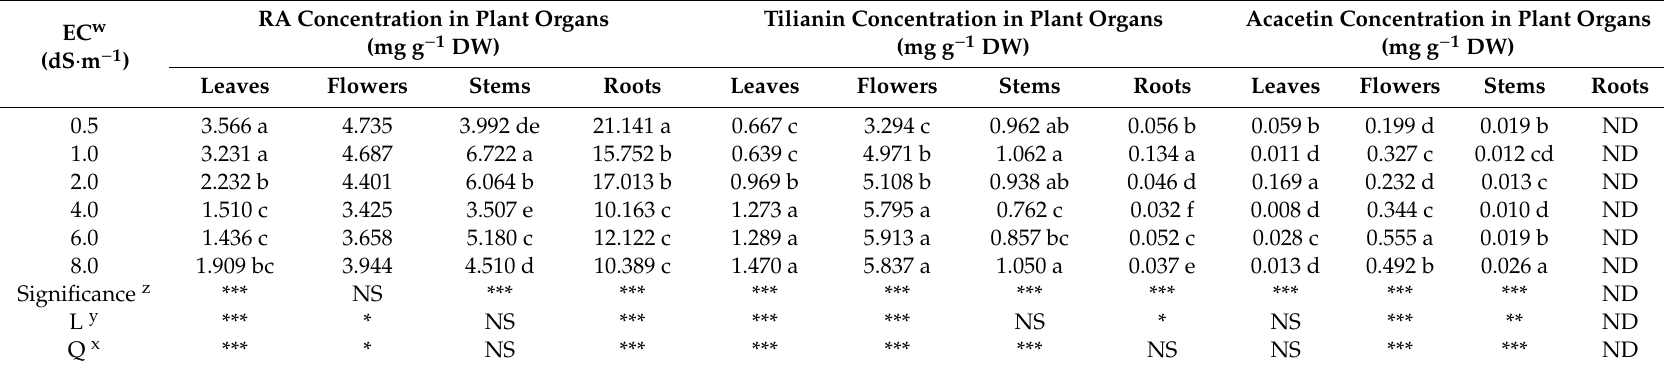
Table 2. Rosmarinic acid (RA), tilianin, and acacetin concentrations (mg g − 1 DW) in leaves, flowers, stems, and roots in A. rugosa grown at di ff erent